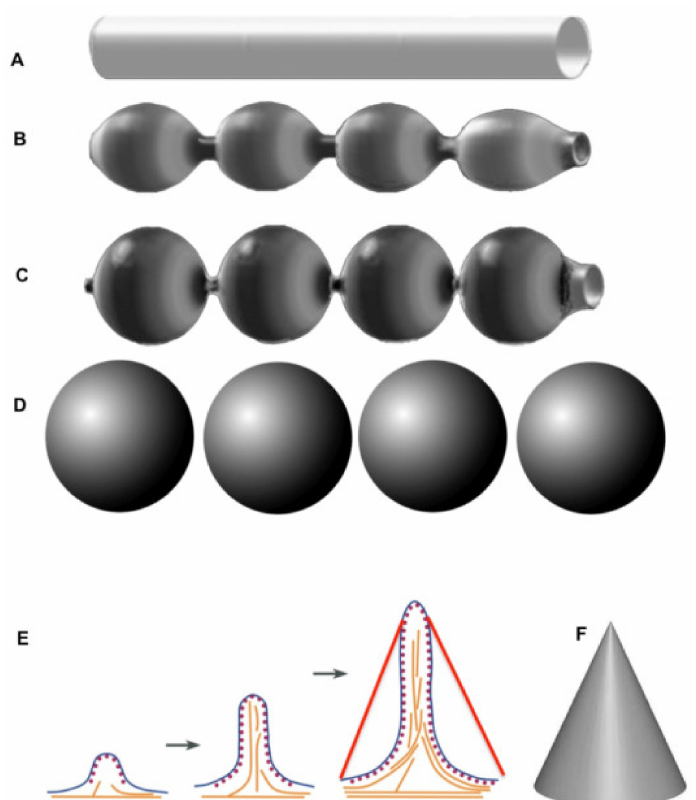
Figure 4. Model describing the mechanism of transformation of a smooth tubule into a row of vesicles. ( A – D ) Consecutive stages of transformation of a cylinder into several spheres, with the preservation of surface area and TAA. When the surface area and TAA of a tubule is equal to the sum of the surface areas of the vesicles the radius of vesicle should be 2.2-fold higher than the radius of the cylinder (tubule). ( E ) Consecutive stages of the filopodia growth. The surface area of the cone ( F ) formed if the membrane was not attached to the actin bundle with ezrin, the surface area of the cone (red lines) would be larger than the surface area of the filopodia membrane and the ring of the plasmalemma around